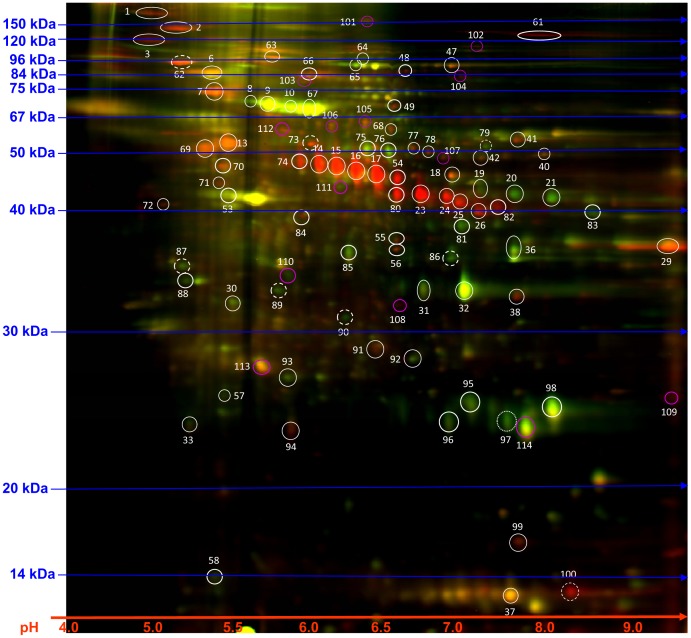
2-D DIGE analysis of A375 exosomes versus HEMa-LP exosomes.25 µg of proteins from A375 exosomes (labeled with Cy5, red) and HEMa-LP exosomes (labeled with Cy3, green) were separated by isoelectric focusing (IEF) in the first dimension and SDS polyacrylamide gel electrophoresis (SDS-PAGE) in the second dimension. Overlay image was generated by ImageQuant software. Differentially expressed protein spots were circled and stored for further protein identification.